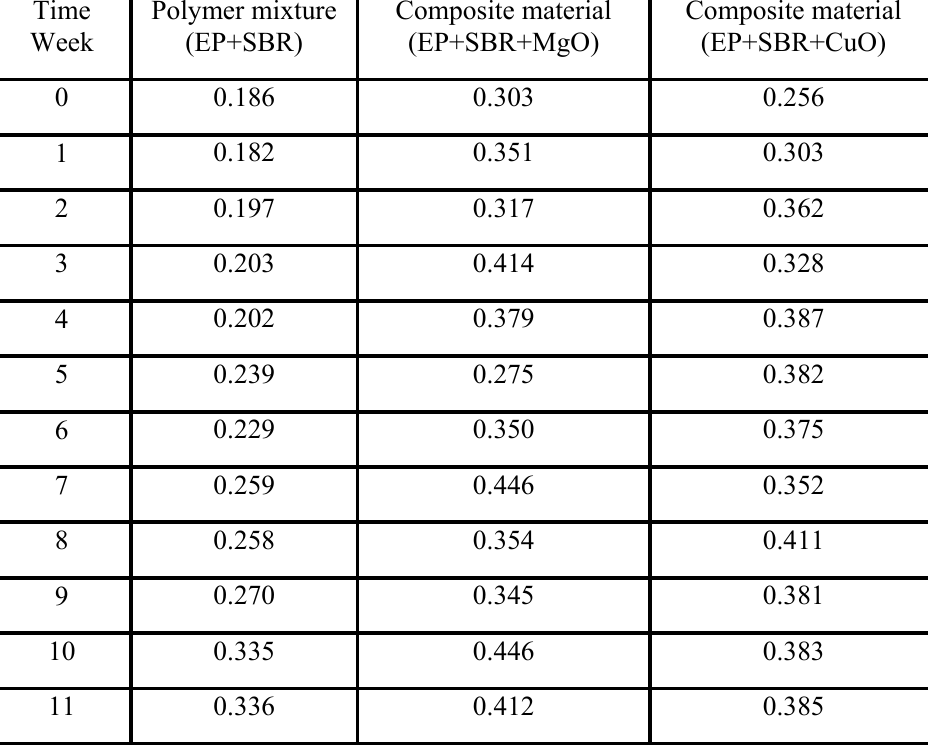
Fig.3: Variation of thermal conductivity with time of immersion for samples. Table 6: The values of thermal